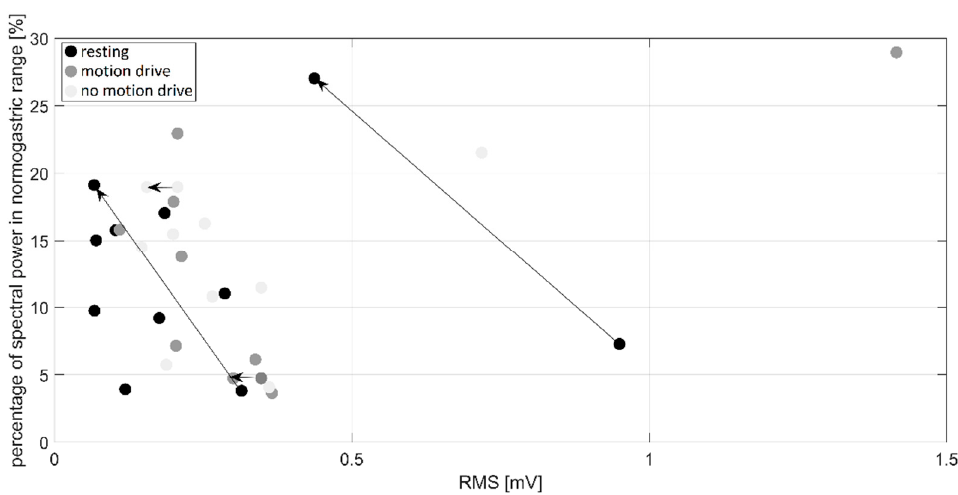
Figure 6. Scatter plot of RMS values and the percentage of spectral power in the normogastric range. Arrows connect points that are associated with the same EGG signal segments, before and after artifact cancellation.